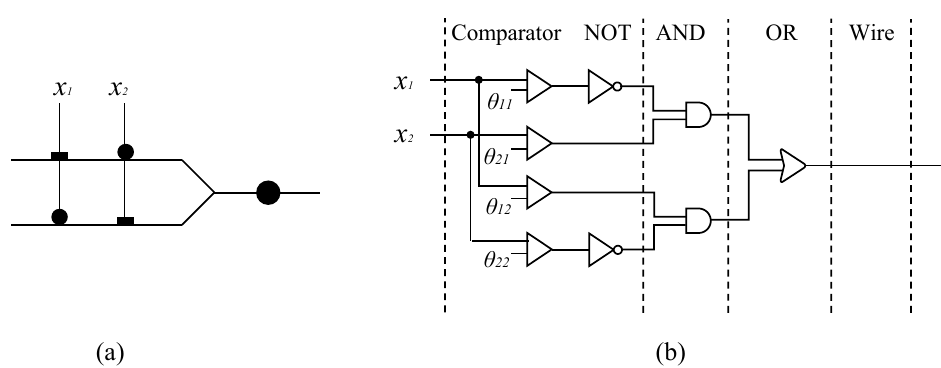
Figure 5. An example of a determined LDNM (subfigure ( a )) and its equivalent logical circuit classifier (subfigure ( b